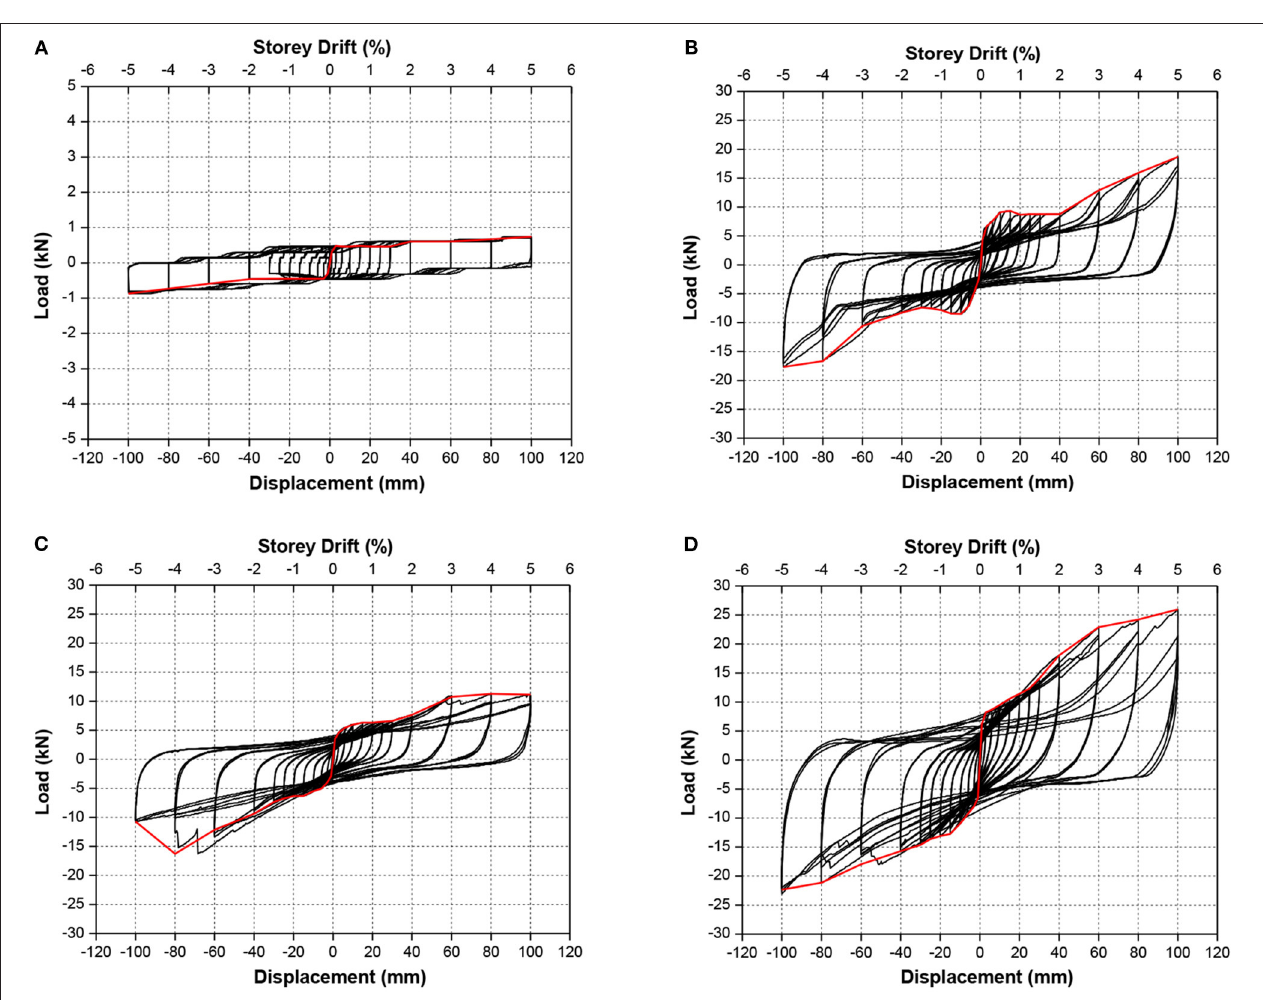
FIGURE 18 | Force–displacement cyclic response of the specimens. (A) Bare frame (Panel zero). (B) Panel MO: semi-interlocking masonry (SIM) infill panel with an open gap at the beam/panel interface. (C) Panel MF: SIM infill panel with foam at the beam/panel interface. (D) Panel MG: SIM infill panel with grout at the beam/panel